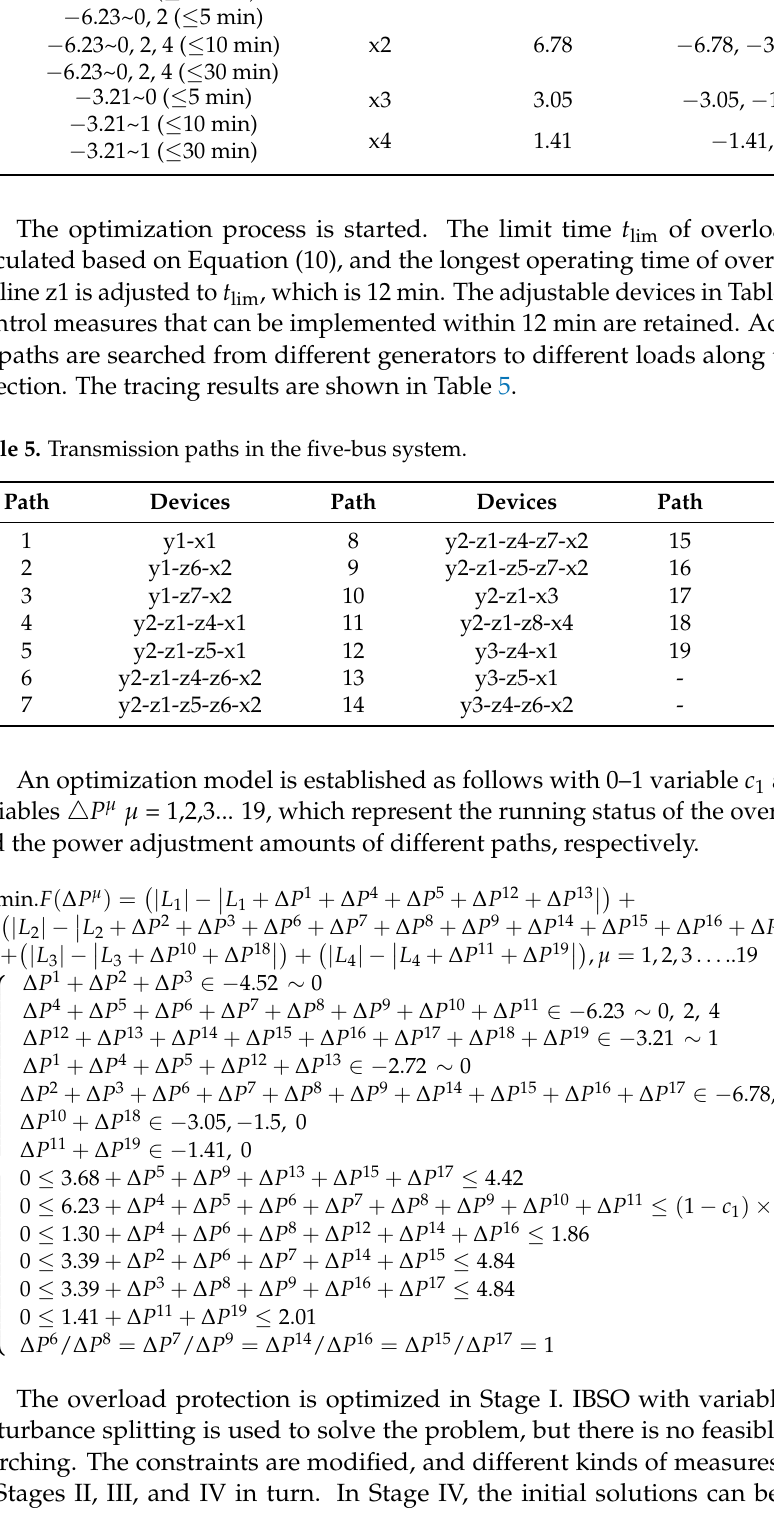
Table 4. Initial and adjustable active power of generators and loads in the five-bus system. Initial Power Power Adjustment Generator (p.u.) Amount (p.u.)